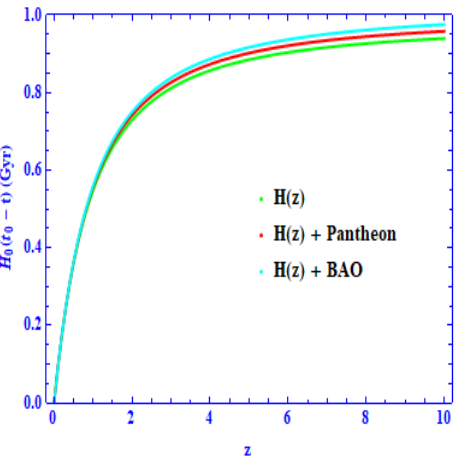
Figure 7. Plot of H 0 ( t 0 − t ) versus redshift z